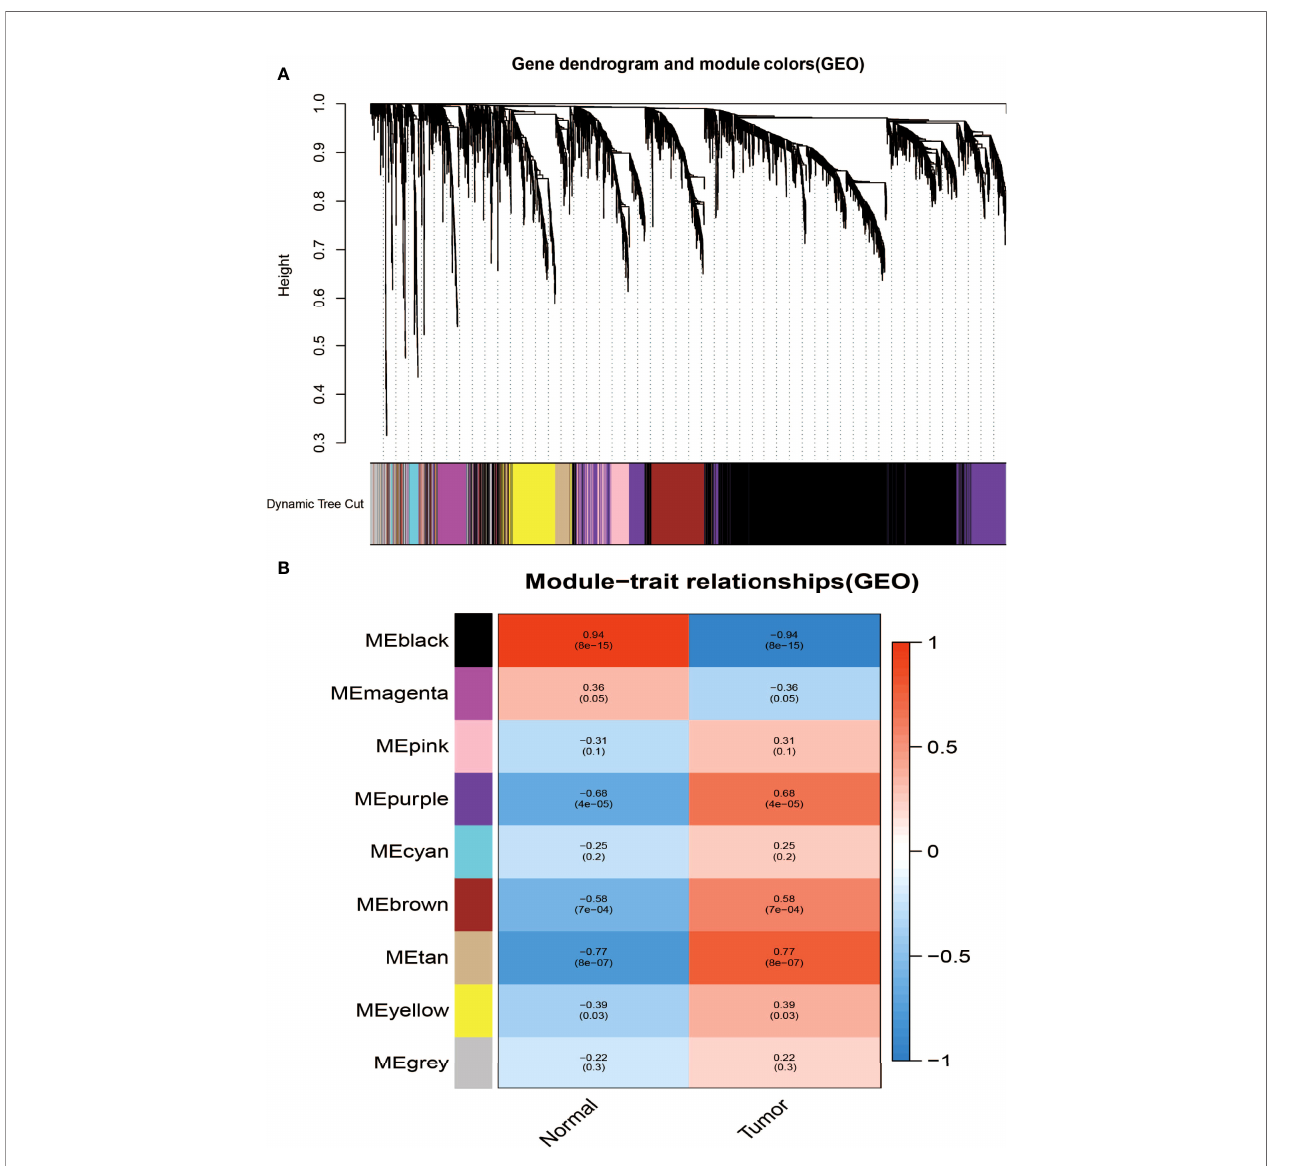
FIGURE 3 | Identi fi cation of modules associated with clinical information in the GSE118916 dataset. (A) The cluster dendrogram of co-expression network modules was ordered by a hierarchical clustering of genes based on the 1-TOM matrix. Each module was assigned different colors. (B) Module – trait relationships. Each row corresponds to a color module and each column correlates to a clinical trait (cancer and normal). Each cell contains the corresponding correlation and P